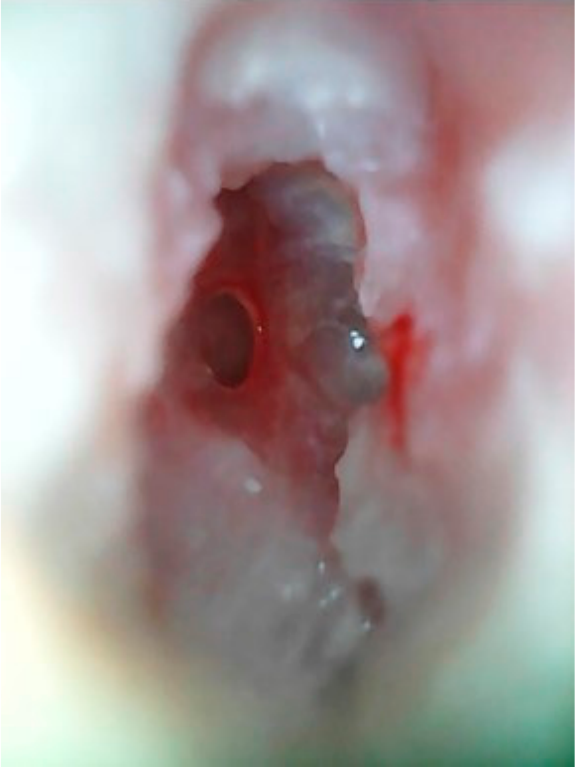
Figure 1. Patient 1, Otomicroscopy: evidence of erosion of the anteroinferior wall of the left EAC and a small anterior tympanic perforation.